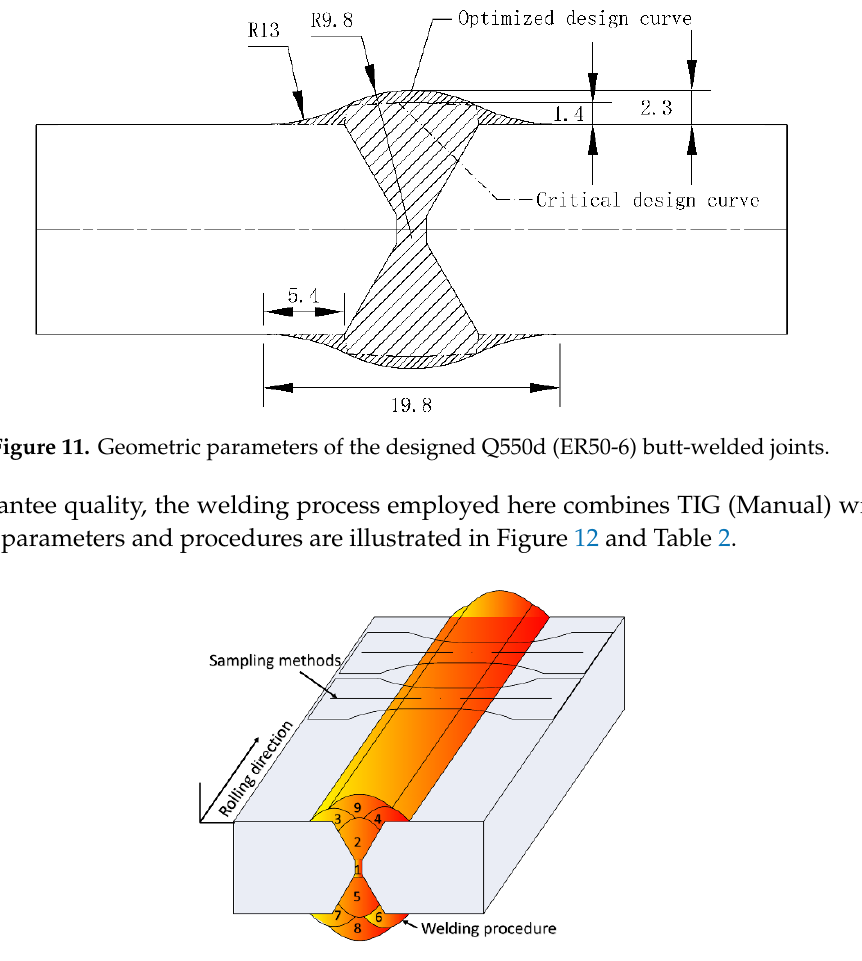
Figure 12. The sampling method and the weld procedure. Table 2. The parameters of the welding